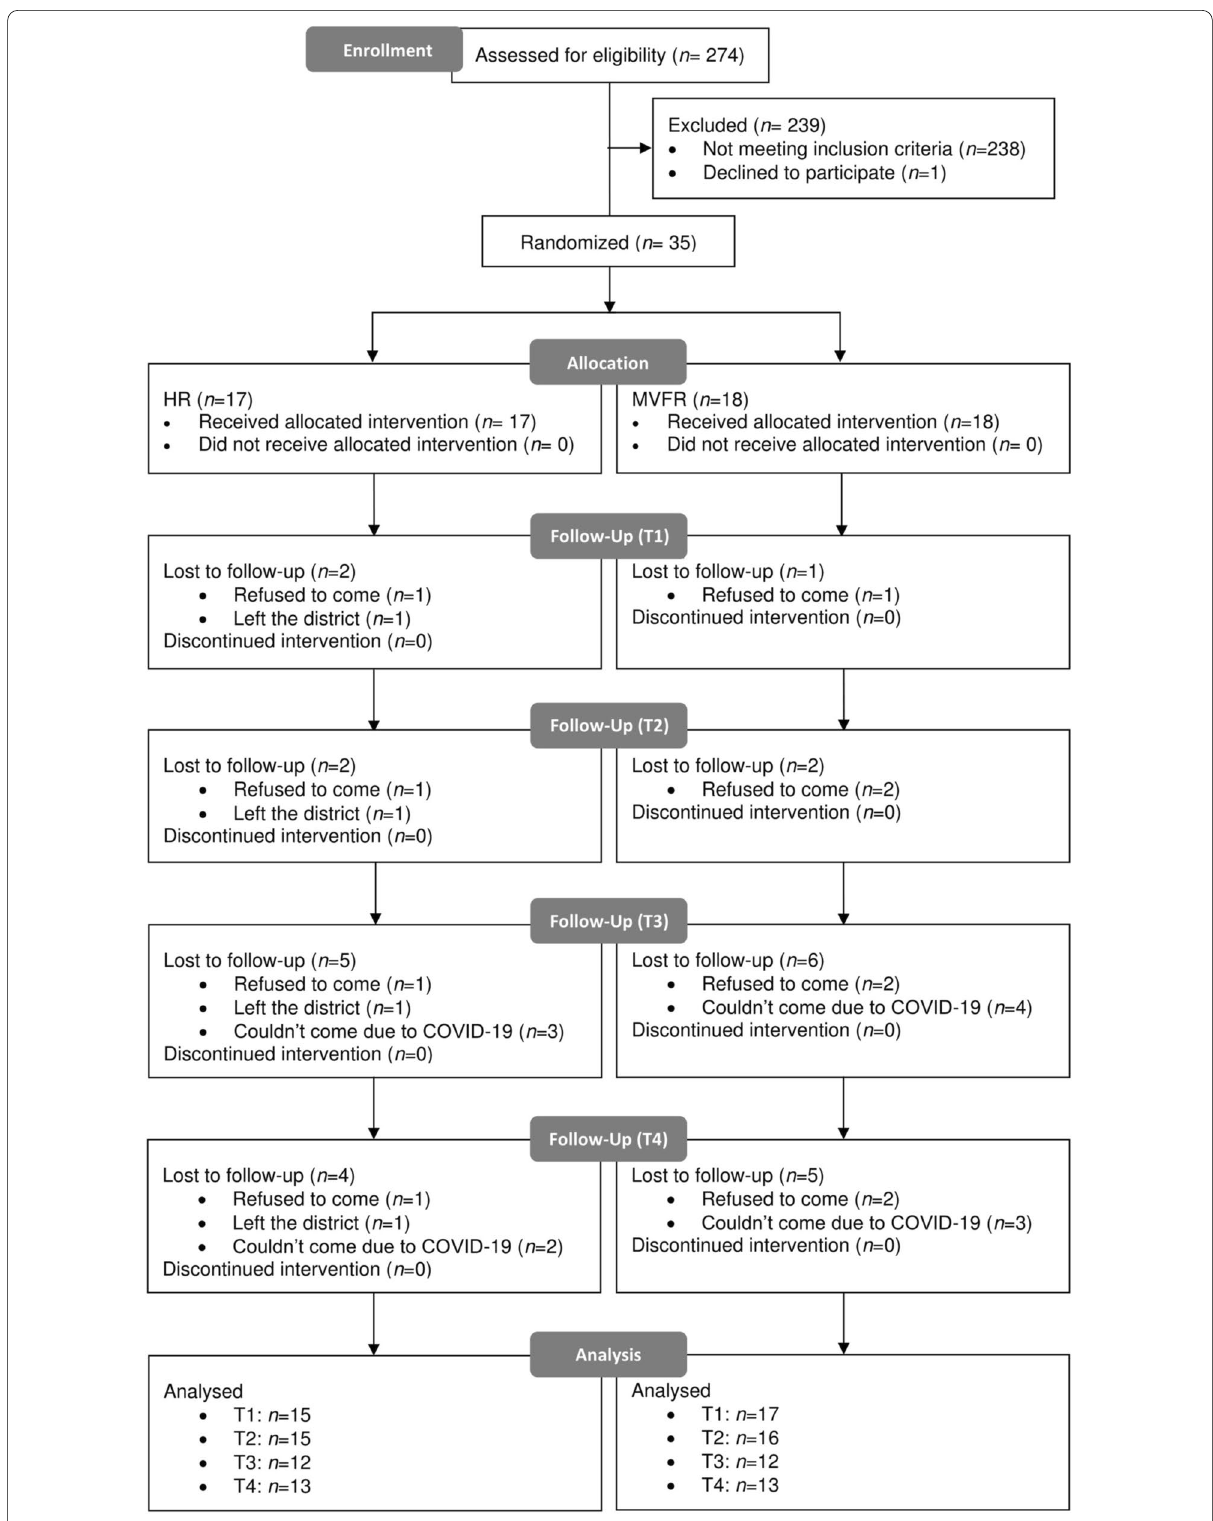
Fig. 3 Consolidated Standards for Reporting of Trials participant flow